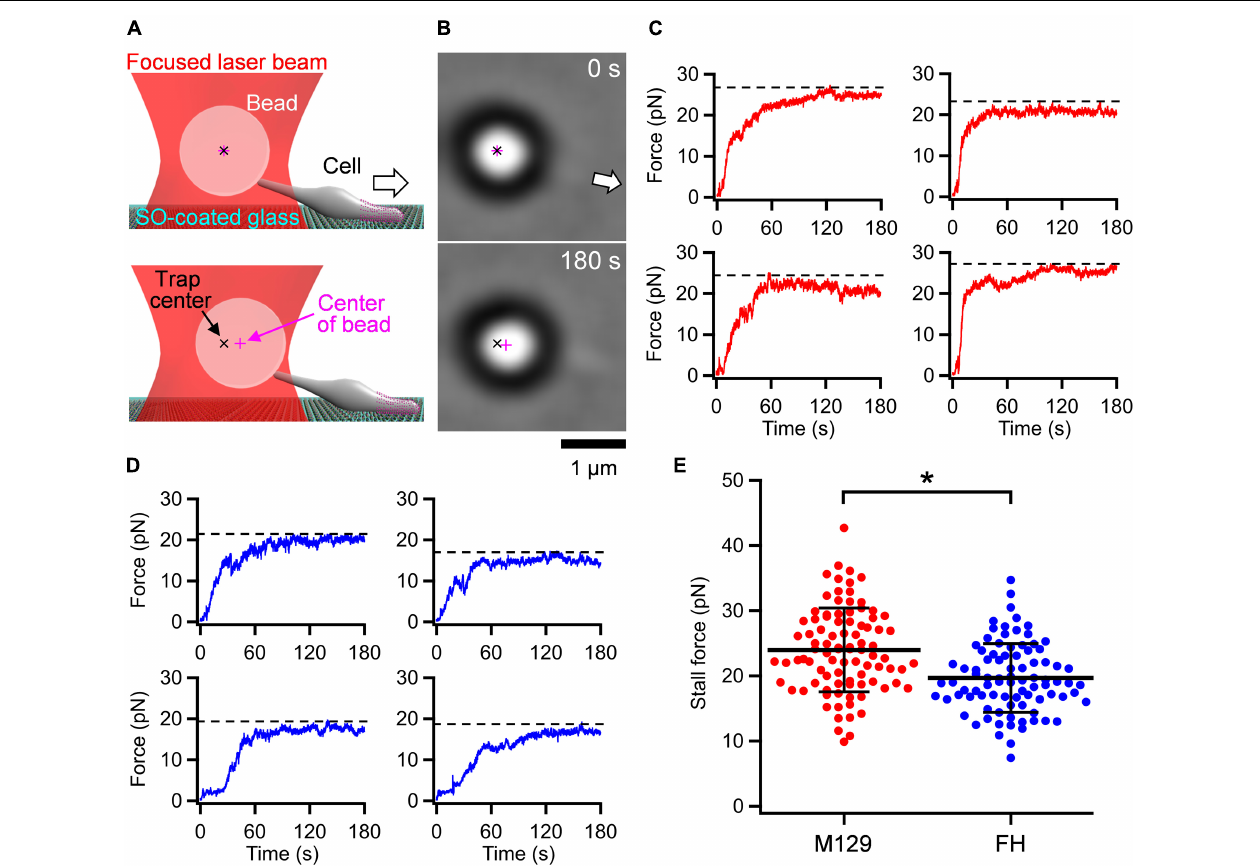
FIGURE 2 | Stall force measurements. (A) Illustrations of experimental design for force measurements. The white arrow indicates the gliding direction. (B) Optical micrographs of trapped cell. The cell attached with a bead (large black ring with white center) glided in the direction of white arrow from 0 and stalled in 180 s. The cell image can be observed near the base of arrow. (C) Four representative time courses of force increments for M129 strain. The broken lines indicate the values of stall force. (D) Four representative time courses of force increments for FH strain. The broken lines indicate the values of stall force. (E) Scatter dot plot of stall force ( n = 92 and 88 in M129 and FH, respectively) shown with averages (thick lines) and standard deviations (thin lines). * p = 2.4 × 10 − 6 by Student’s t